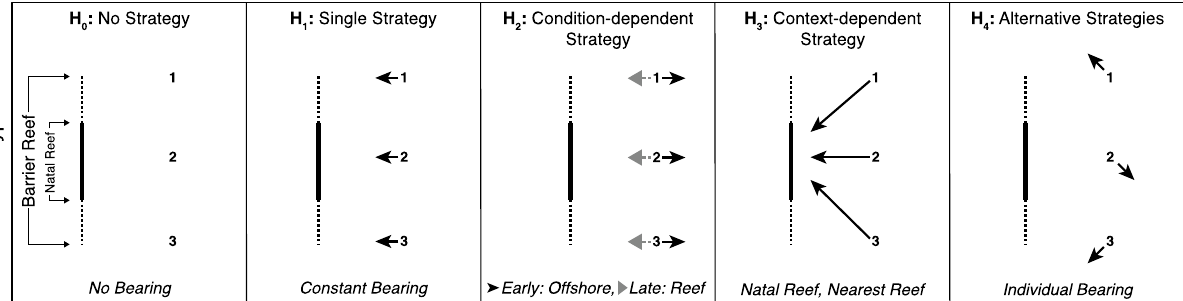
Figure 5. Alternative hypotheses for the goal of larval orientation behavior. (H 0 ) No strategy, individual larvae may not swim directionally. (H 1 ) Single strategy, all larvae share a common, constant bearing. (H 2 ) Condition- dependent strategy, the optimal bearing changes depending on the ontogenetic or physiological state of individual larvae. (H 3 ) Context-dependent strategy, the optimal bearing depends on an individual’s location. (H 4 ) Alternative strategies, the optimal bearing depends on the frequency with which that bearing is adopted by other individuals in the population. Numbers—indicate the position of three hypothetical larvae with respect to a linear reef. Arrows—indicate the expected direction of orientation for each